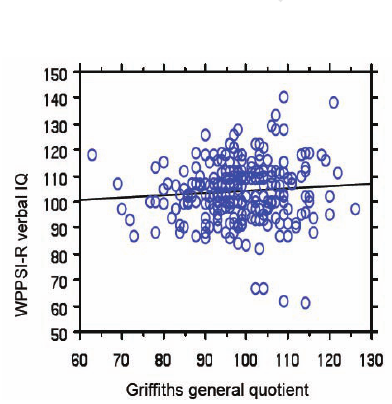
Figure 3. Regression plot of WPPSI-R ver- bal IQ and Griffith general